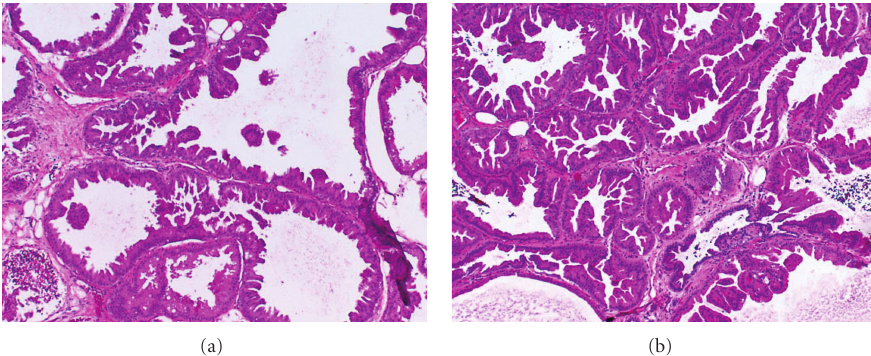
Figure 1: Representative examples of MRI-guided breast needle core biopsies showing a characteristic benign complex multicystic lesion lined by apocrine metaplastic epithelium, called “cystic apocrine metaplasia.” This benign lesion was seen in 38% (11/29) of the benign MRI-guided needle core biopsies in this series.